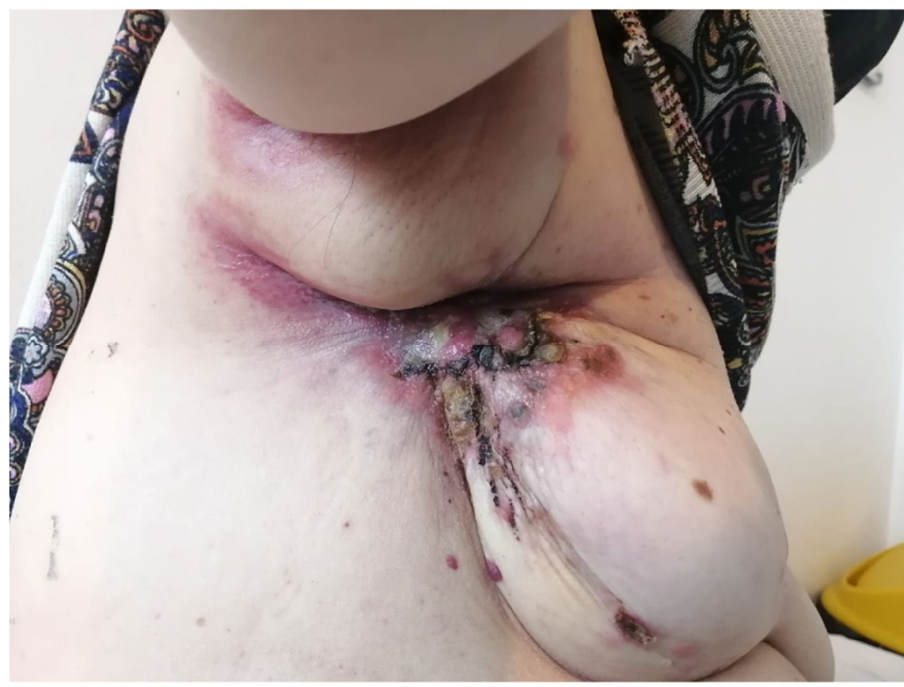
Figure 1. Clinical presentation of the left breast with ulceration and macroscopic nodules.